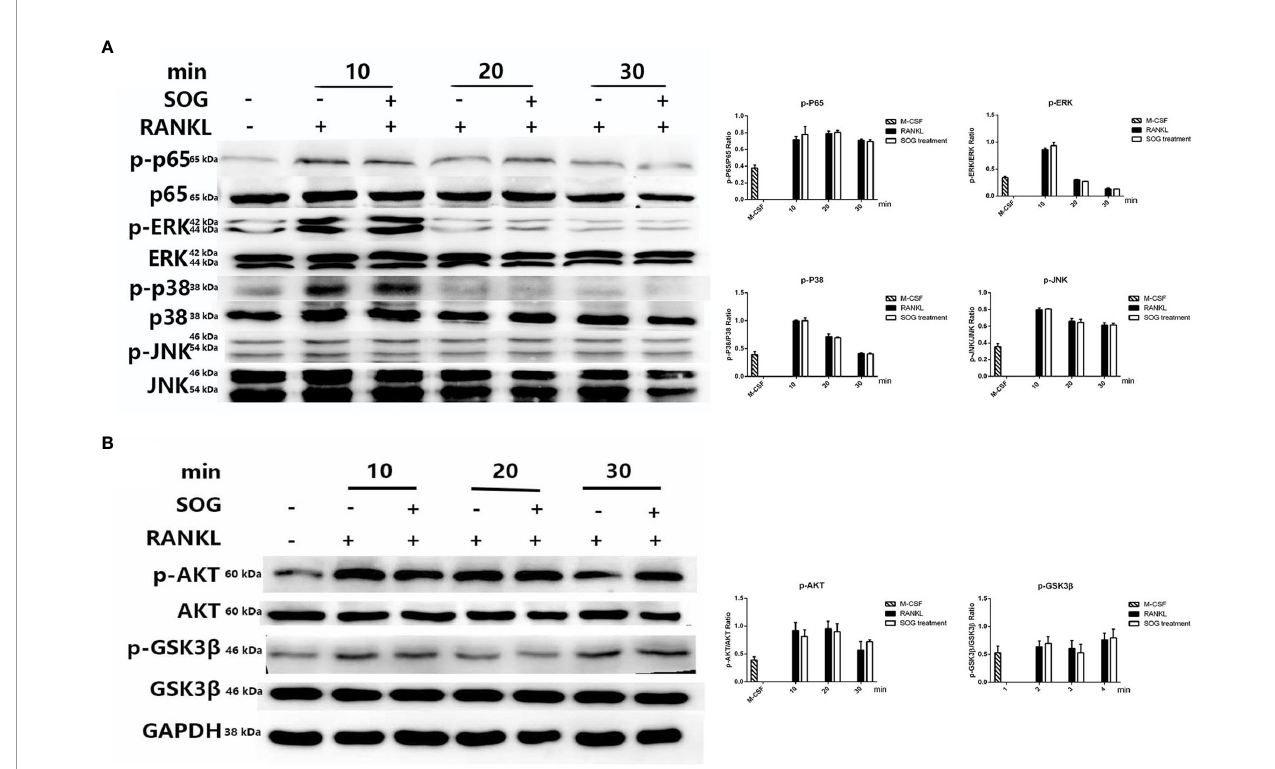
FIGURE 4 | The effects of 200 µM SOG pretreatment on 100 ng/mL RANKL-induced NF- k B, MAPK, and AKT-GSK3 b signaling in BMMs as assessed by western blotting. (A) Phosphorylation of the NF- k B p65 subunit and MAPKs including ERK1/2, JNK, and p65. (B) Phosphorylation of AKT and GSK3 b . Relative band intensities of phosphorylated proteins were normalized to that of the un-phosphorylated protein. All experiments were performed at least three